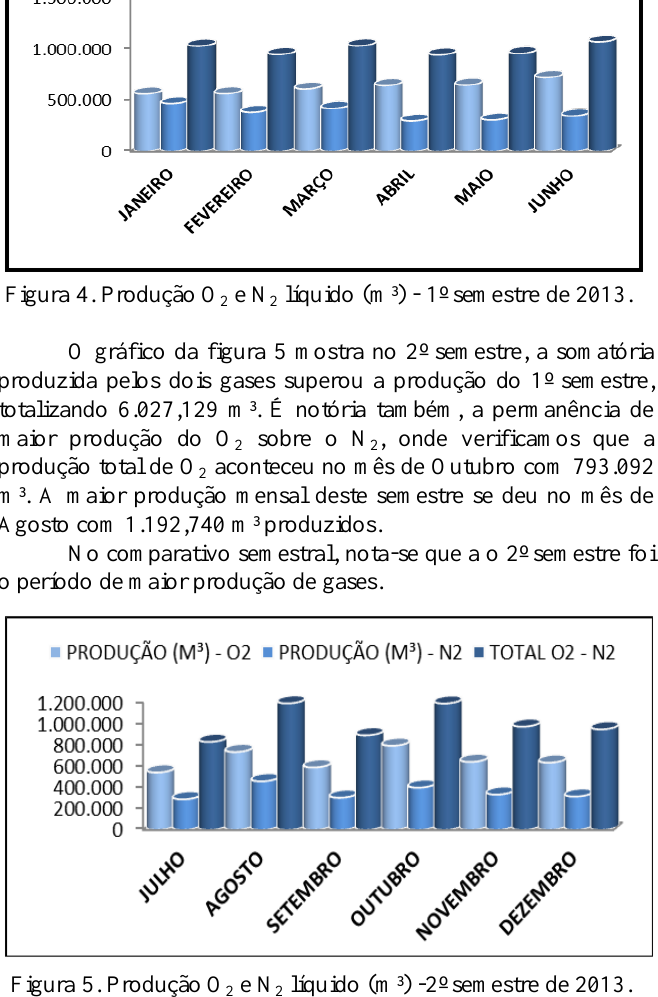
Figura 3. Enchimento de carro-tanque.